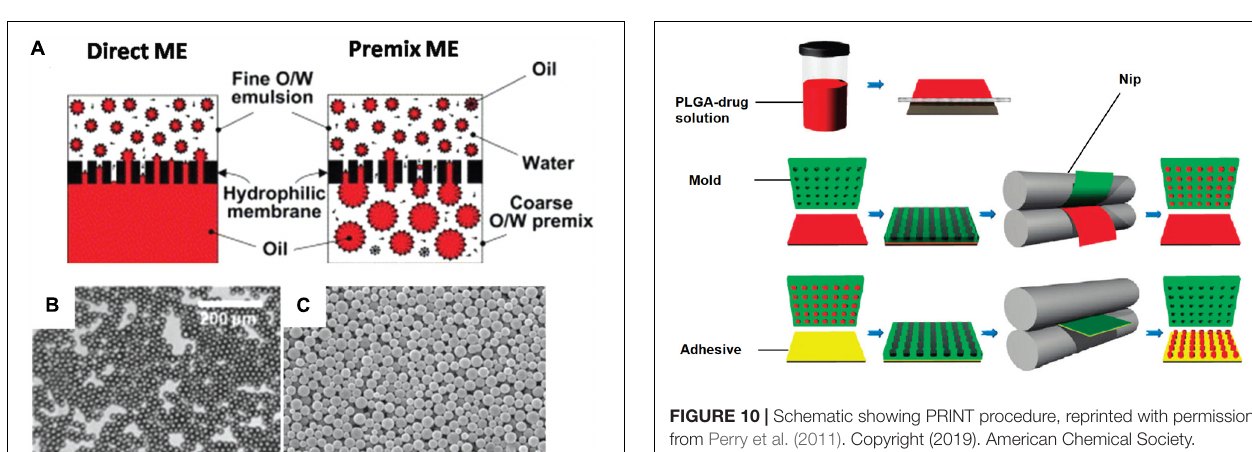
Frontiers in Bioengineering and Biotechnology |